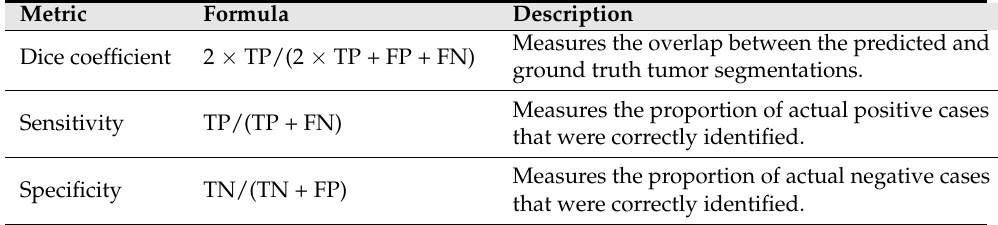
Measures the overlap between the predicted and ground truth tumor segmentations. Measures the proportion of actual positive cases that were correctly identified. Measures the proportion of actual negative cases that were correctly